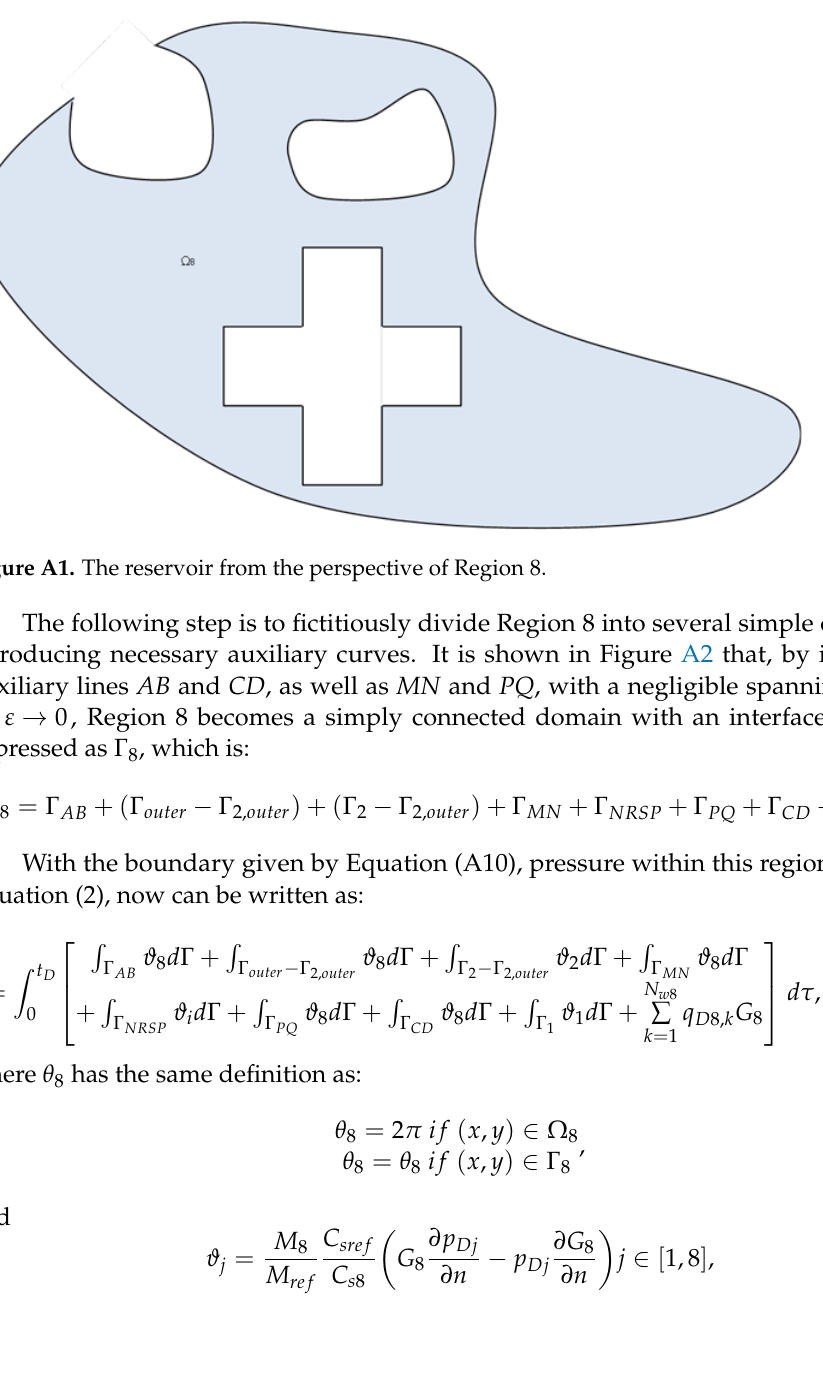
Figure A2. Region 8 fictitiously divided into a simply connected region.